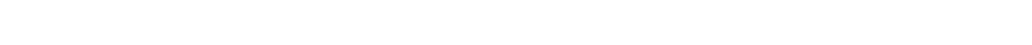
Frontiers in Energy Research | Carbon Capture, Storage, and